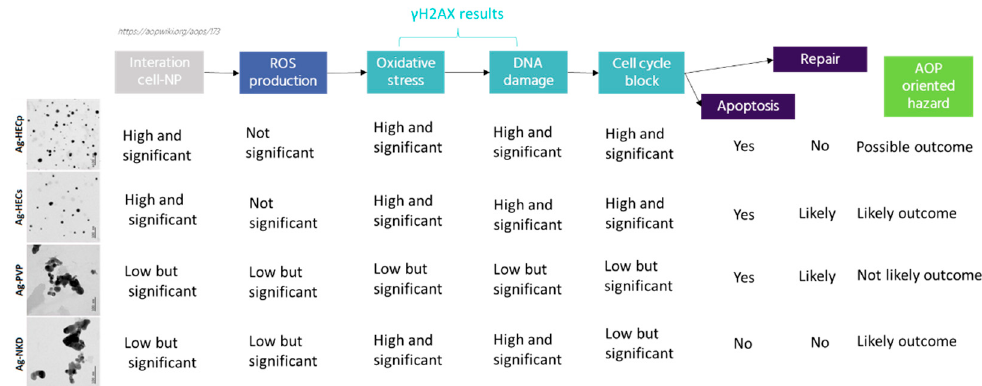
Figure 10. Summary of the AOP-oriented test analysis for the different NPs analyzed. Among the different NPs, the newly produced are the most likely to activate relevant events related to AOP #173, lung fibrosis, and therefore pose a relevant hazard for human health. The reference materials (AgNKD and AgPVP) are less relevant in the framework of the AOP selected. Significantly, the AOP events investigated clearly showed that the AgHECp are activating all the relevant events that may link the exposure to these NPs to the adverse lung outcome, while the AgHECs are less likely to determine such detrimental effects.